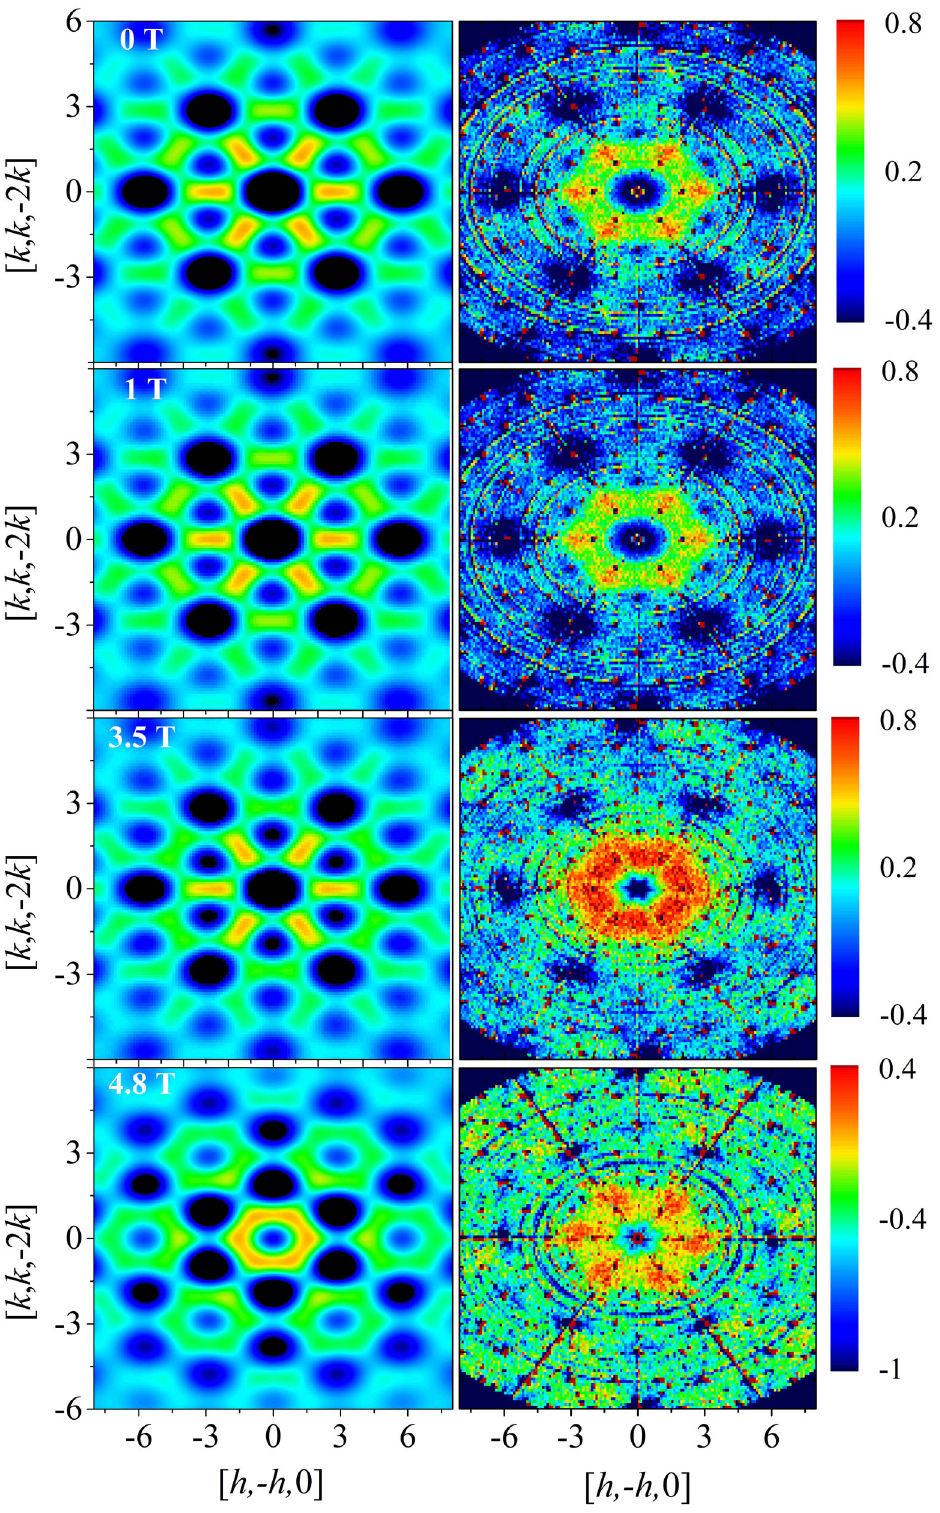
Fig. 5 Diffuse neutron scattering results. Comparison of the experimental (right) and theoretical (left) energy-integrated structure factor at several magnetic fi elds H ∥ [111] (0, 1 T, 3.5 T, and 4.8 T) using the single tetrahedron model. Theoretical plots include the atomic form factor of Yb 3 + . Experimental data were measured using the Wide Angle Neutron Diffractometer (WAND 2 ). Both experimental and theoretical plots show the data at T = 70 mK after subtracting the background at 50 K at 0